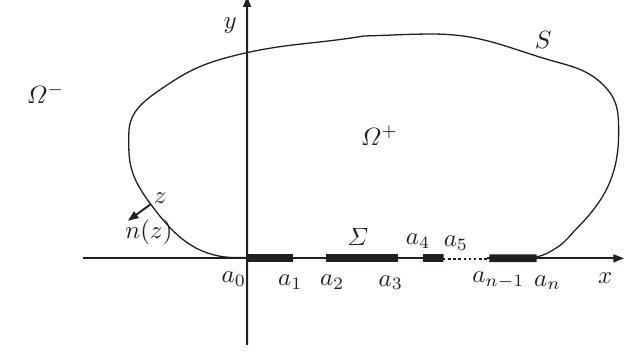
Figure 1. The geometry of the